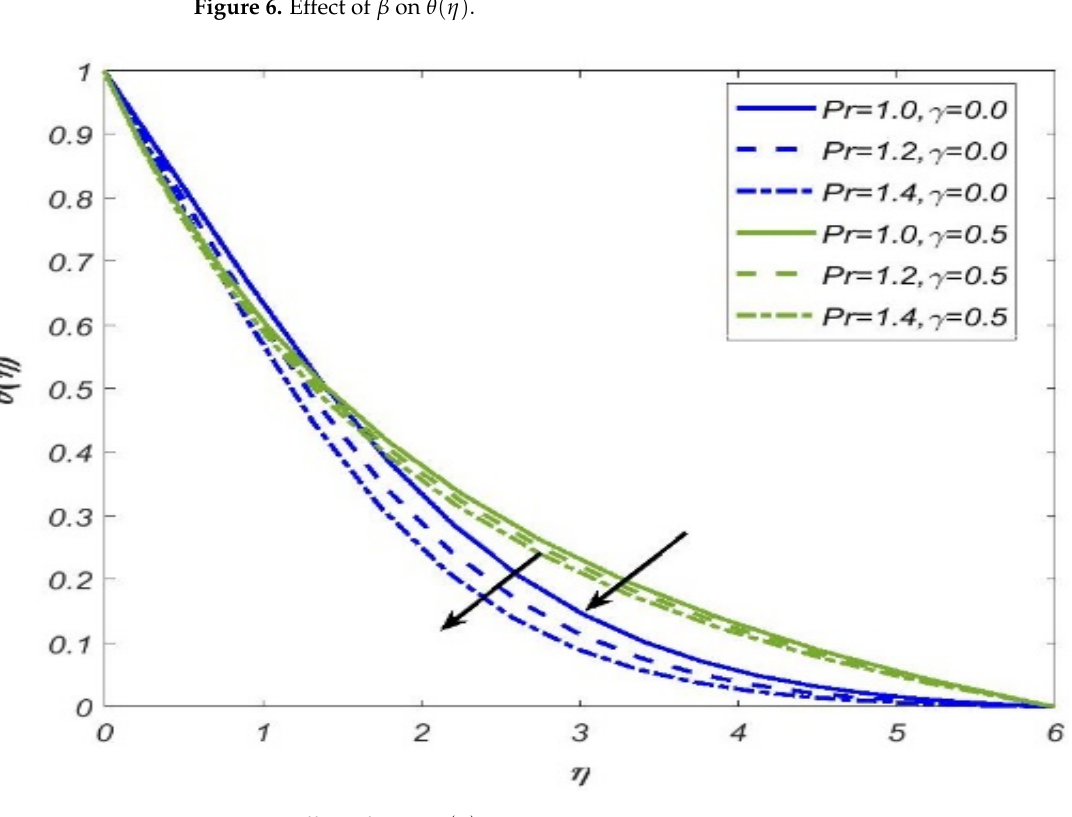
Figure 7. Effect of Pr on θ ( η )